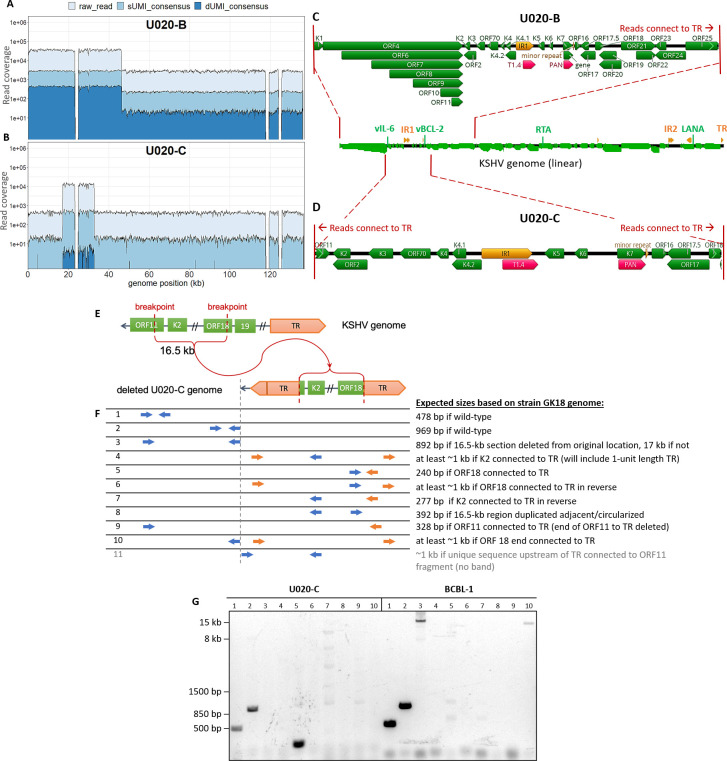
KSHV genomes in U020-B and U020-C have large, distinct deletions.Total, sUMI and dUMI-consensus read coverages of U020-B (A) and U020-C (B) KSHV genomes. GK18 reference annotations in the high-coverage regions of U020-B (C) and U020-C (D). (E) Cartoon showing the region encompassing the high coverage region of U020-C viral genomes, leaving a 16.5-kb region connected to TR. (F) PCR primers used to examine genome structure. Primers to unique genomic sequences are in blue, and primers to repeat sequences are in orange. (G) PCR products produced from primer pairs numbered in E, with DNA from U020-C and BCBL-1 as templates. Bands from lanes 1, 2 and 5 were excised from the agarose gel and sequenced. Faint bands in lanes 7 (five bands) and 9 (one) under U020-C were extracted from the gel but did not yield enough DNA for Sanger sequencing, except for the light 1-kb band in lane 7. Top BLAST hits to this sequence were human phosphatidylserine synthase 2 gene sequences, likely amplified due of spurious primer homology. The ~16 kb band in lane 3 under BCBL-1 was confirmed by Sanger sequencing to be ORF11 and ORF18 sequences from its two ends, and lane 10 under BCBL-1 corresponded to sequences common to many cloning vectors such as pCMV-VEE-GFP. Row 11 primers in (F), in which the forward primer binds to unique genomic sequences preceding the TR, yielded no discernible product.